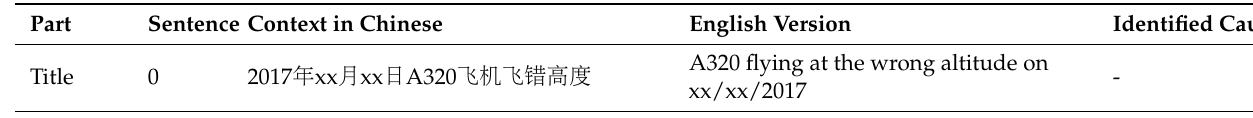
Table 8. Example illustration of cause